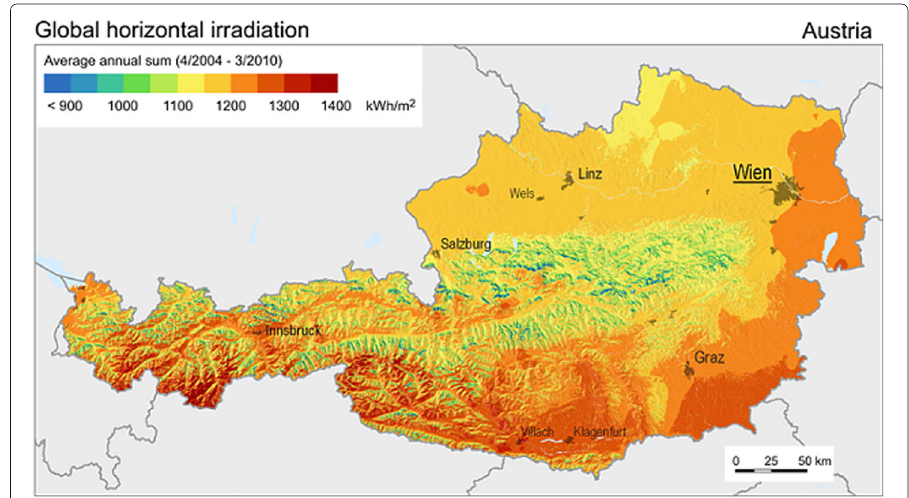
Experimental setup